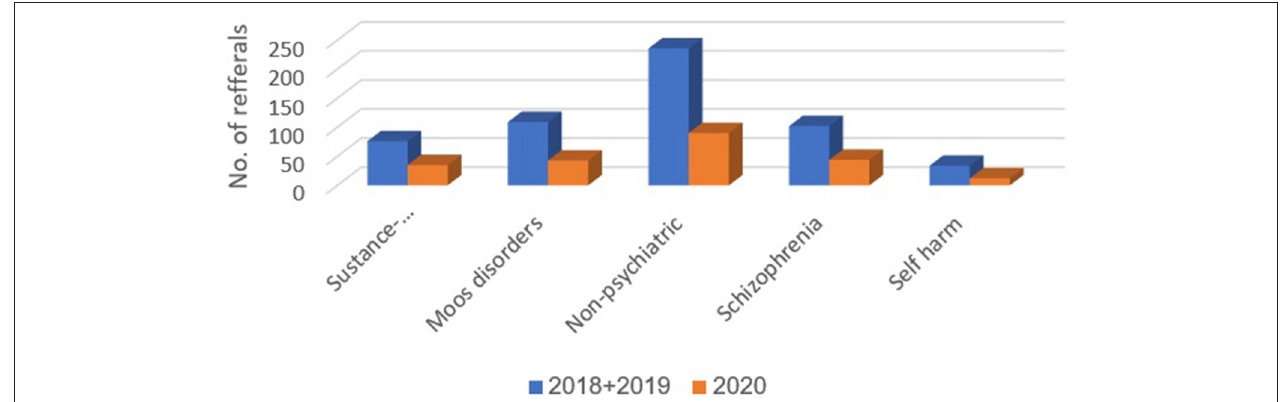
FIGURE 4 | Representation of diagnoses that remained the same in proportion of